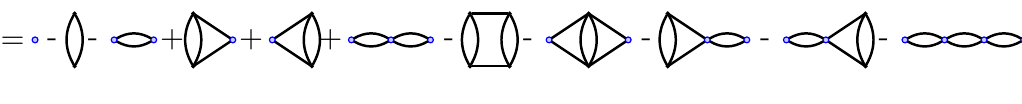
Figure 5 . The bare series up to quartic order. For g 1 the blue vertices represent (cid:21) 1 and the rungs contribute (cid:21) 2 , while for g 2 the blue vertices represent (cid:21) 2 and the rungs contribute 3 (cid:21) 2 . where e 2 G denotes the edges of G and T runs over the spanning trees in G (see for side in (cid:12)gure 5 are, from left to